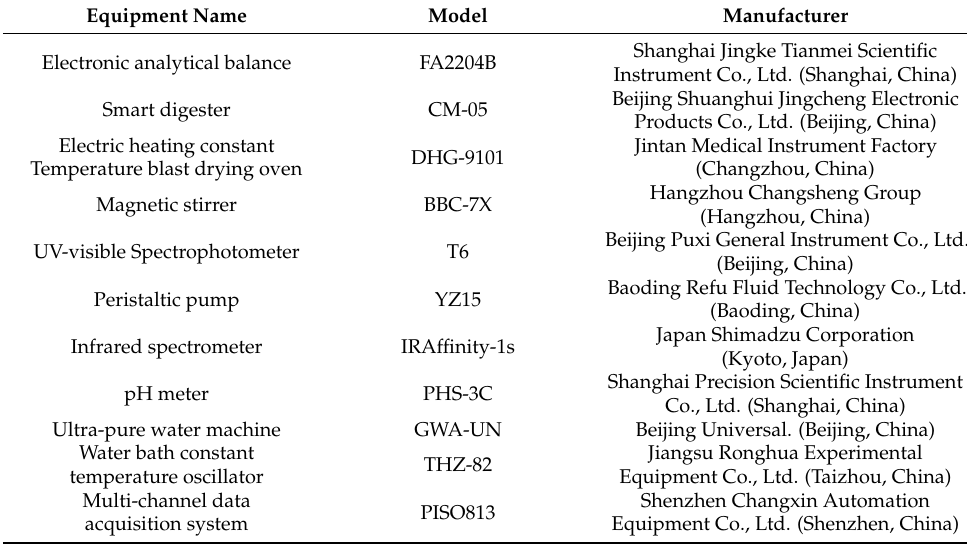
Table 1. List of the main instruments and equipment used in the